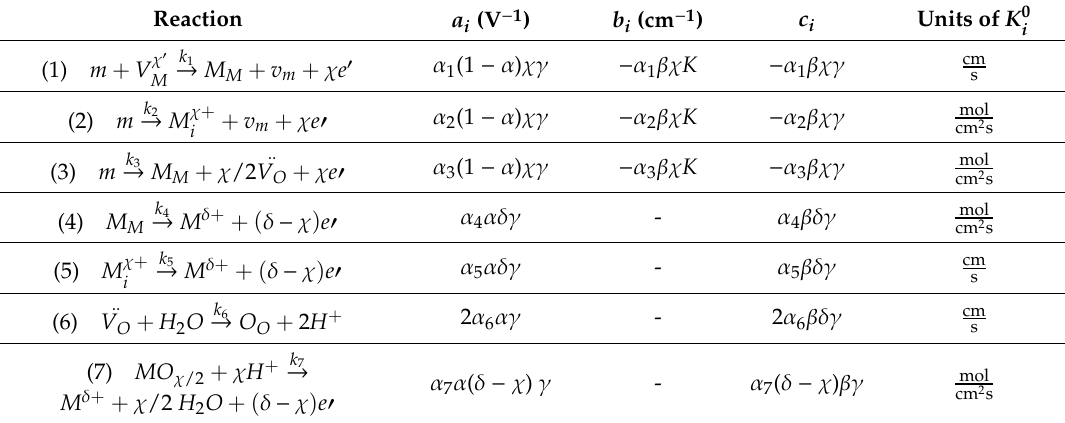
Table 1. Coe ffi cients for the rate constants for the reactions that generate and annihilate point defects at the m / bl interface (Reactions (1)–(3)) and at the bl / s interface (Reactions (4)–(6)) in Figure 7 and for dissolution of the film (Reaction (7)) [33,38–40]. K i = K 0